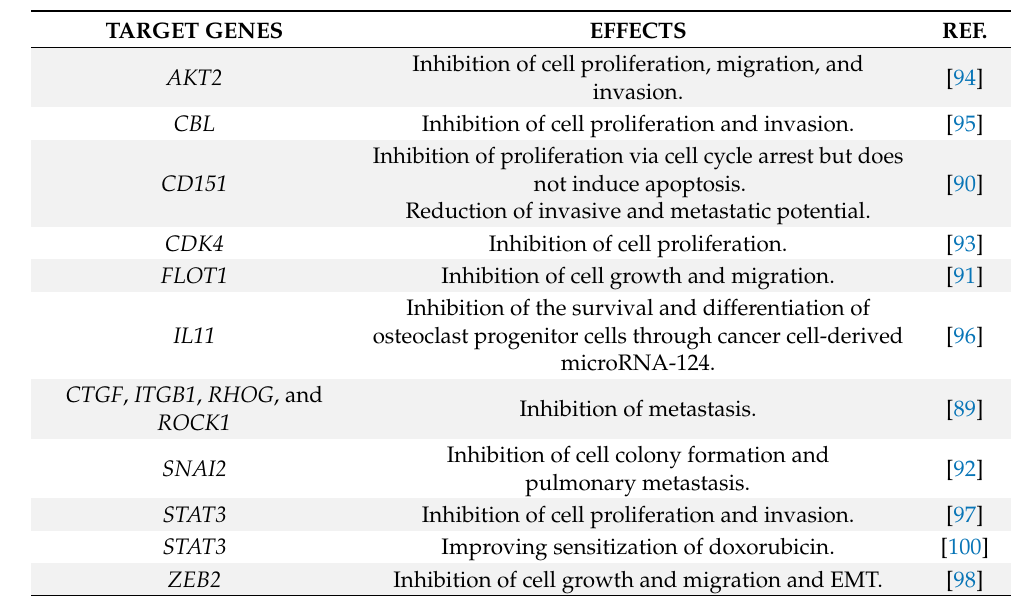
Table 6. Anti-tumor function of miR-124 in breast